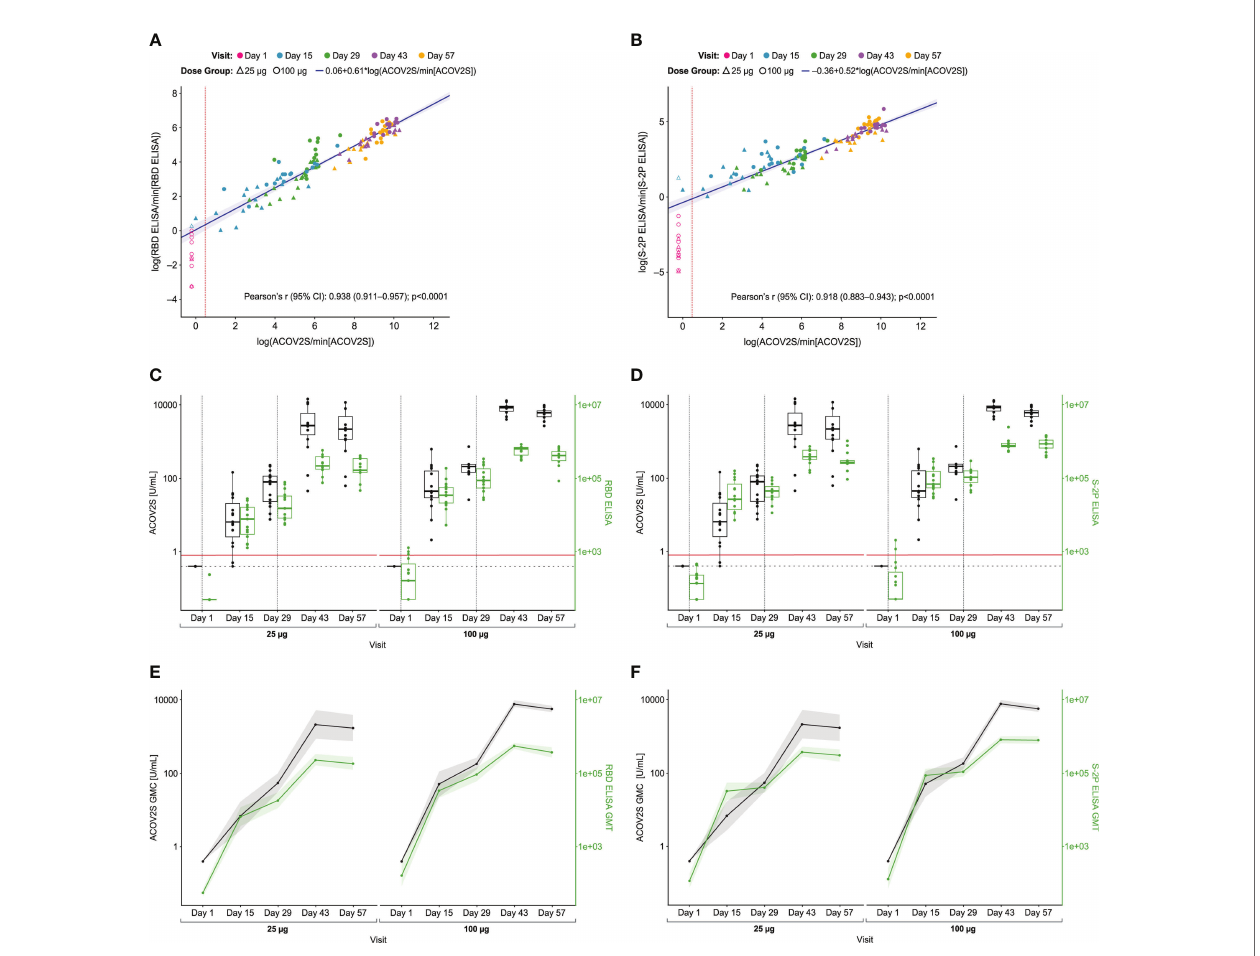
FIGURE 3 | Comparison of ACOV2S and ELISA. Passing – Bablok regression fi t (log-scale) for the comparison with RBD ELISA is shown in (A) , and with S-2P ELISA in (B) Red dotted line shows ACOV2S reactivity cut-off. The shaded area represents the 95% con fi dence interval for the fi tted curve. Dots and triangles represent individual samples; fi lled dots or triangles represent samples within the measuring range for the ACOV2S assay. Time courses of antibody responses measured by RBD ELISA and S-2P ELISA compared to ACOV2S are shown in (C, D) , respectively. Dotted grey vertical lines show when vaccination injections were administered at Days 1 and 29. Red horizontal line shows ACOV2S reactivity cutoff, and the black dashed horizontal line represents the lower end of the ACOV2S measuring range. Box plots show the individual readouts (dots) and, 25th, 50th, and 75th percentiles (box). Time-dependent geometric mean concentrations and geometric mean titers across vaccine dose groups of ACOV2S levels vs RBD ELISA and S-2P ELISA are shown in (E, F) , respectively. Shaded areas indicate 95% con fi dence